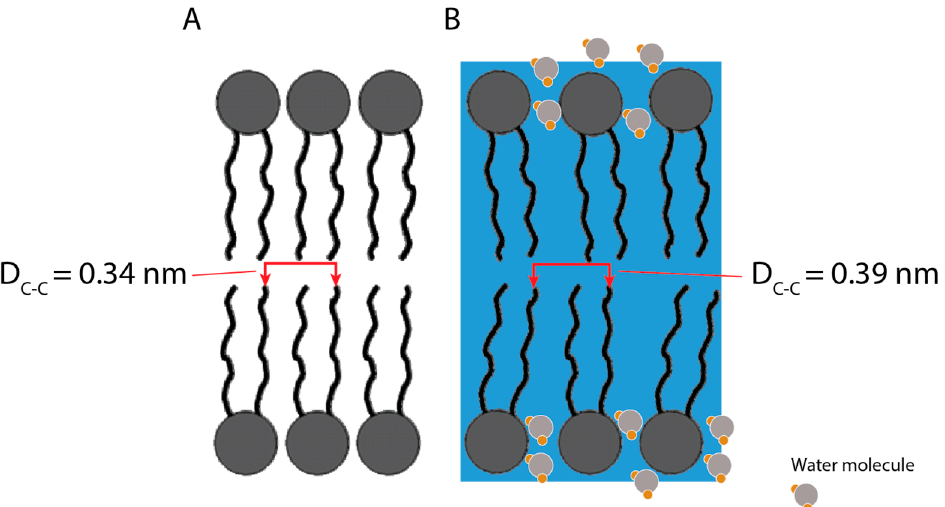
Figure 13. Schematic representation of the lipid structure in liposome mono-bilayer prepared via ( A ) microfluidics, ( B ) thin-film rehydration (blue square and stylized water molecules represent high hydration level). The inter-chain distance differences as well as the degree of disorder are exaggerated in the schematic to highlight the structural differences of both preparation methods.